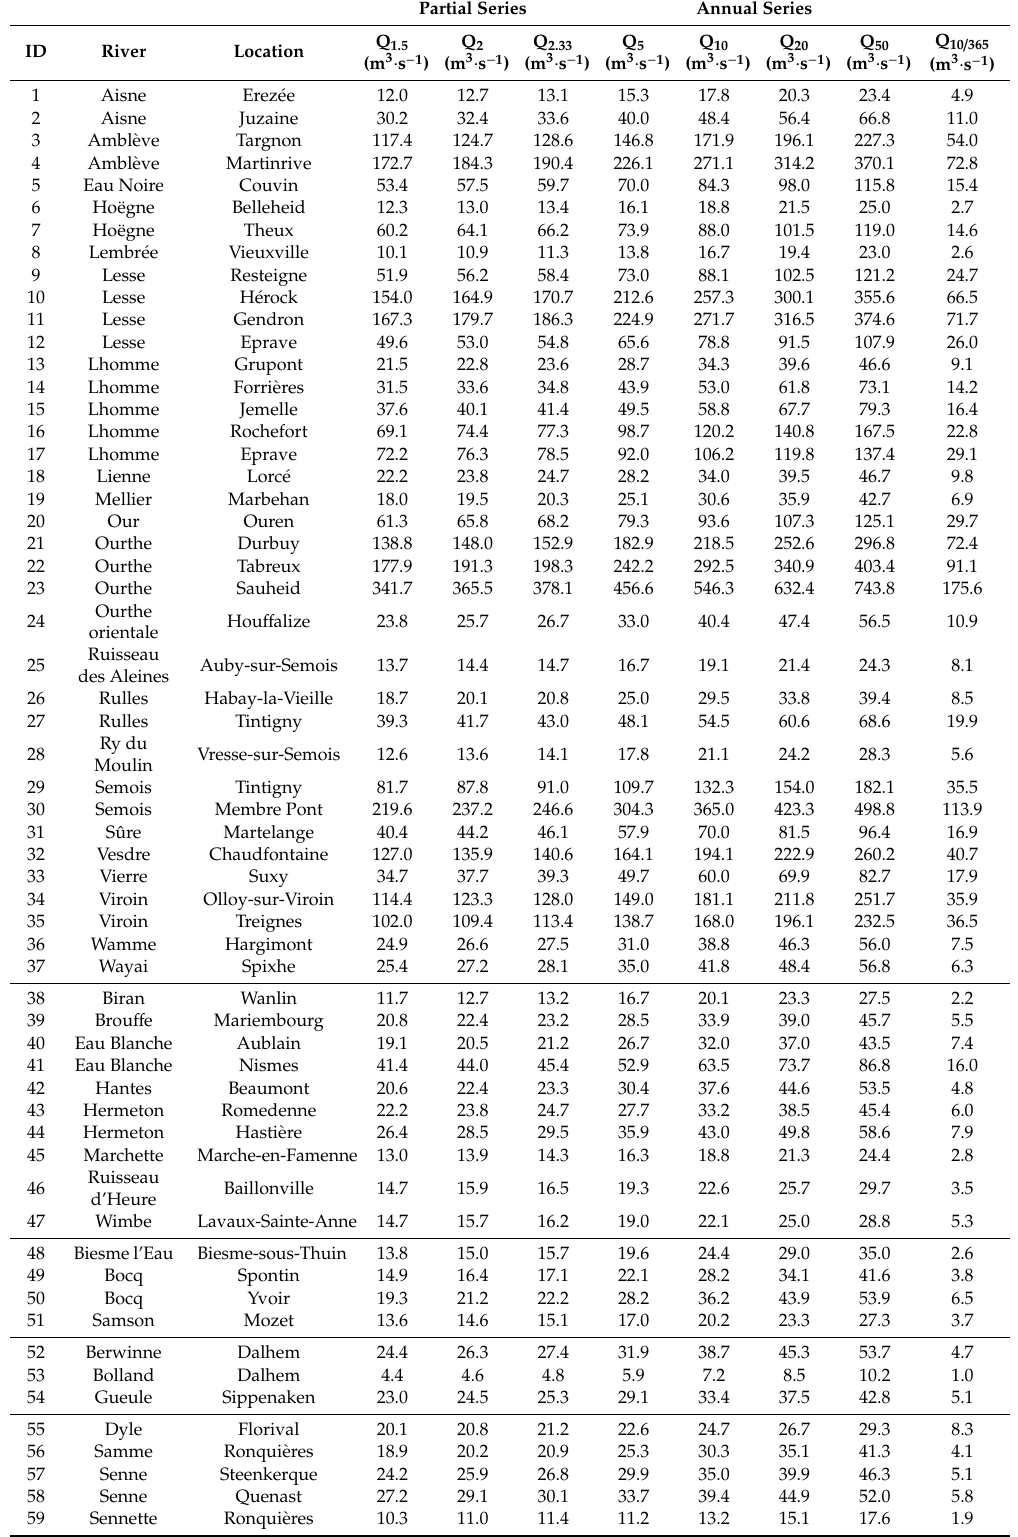
Table A1. Characteristic discharges computed for the selection of hydrologic stations Partial